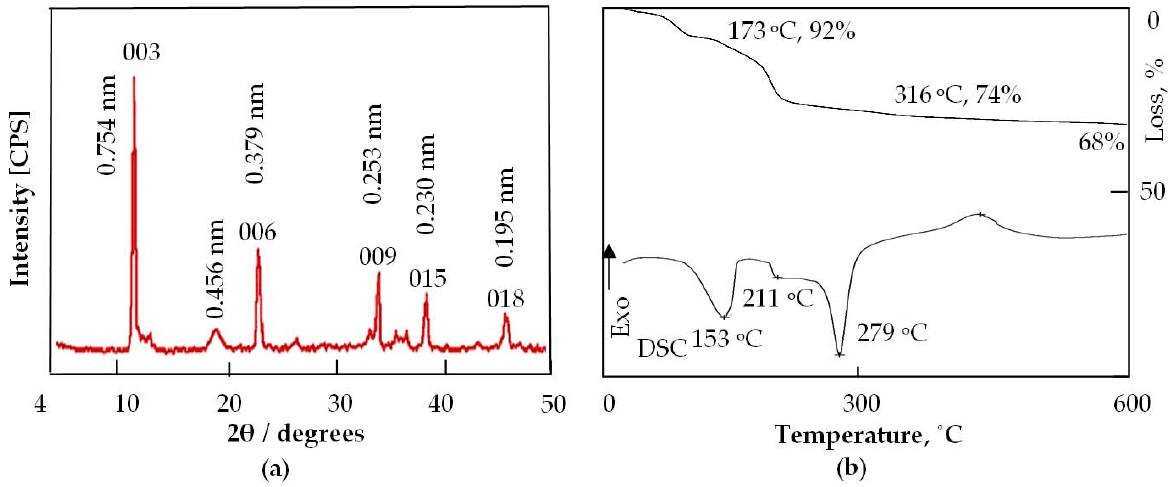
Figure 4. Sample ZA ‐ 3: ( a ) X ‐ ray diffraction and ( b ) thermal analyses. Figure 4. Sample ZA-3: ( a ) X-ray diffraction and ( b ) thermal analyses. Figure 4a revealed a weak peak appearing at 2 θ = 19.4° (d ‐ spacing = 0.456 nm) cor ‐